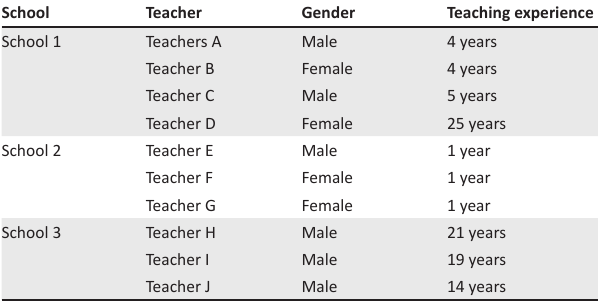
TABLE 1: Research site and